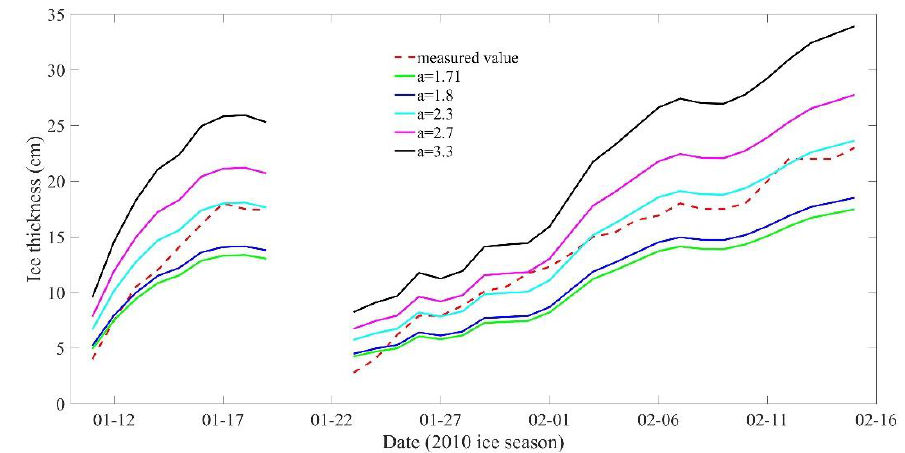
Figure 8. Simulation results under different growth coefficients. Table 1. Simulation error at different growth coefficients.